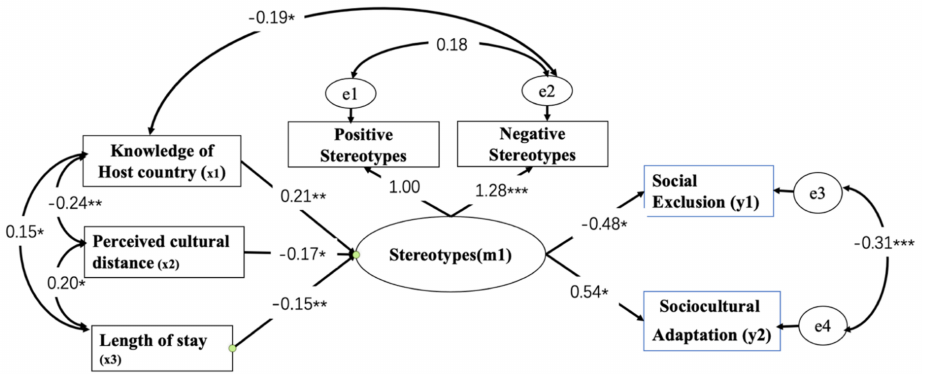
Figure 3. Latent stereotype structural model ( χ 2 (8) = 13.092, p = 0.109, CFI = 0.976; RMSEA = 0.061).